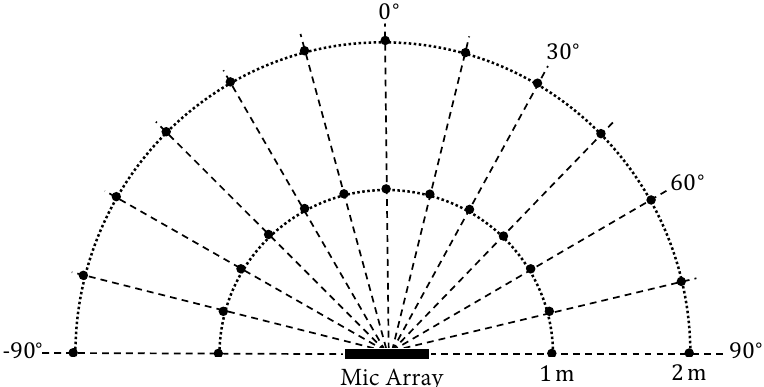
2 m Figure 3. The evaluation setup. The black dots mark the positions where the impulse responses